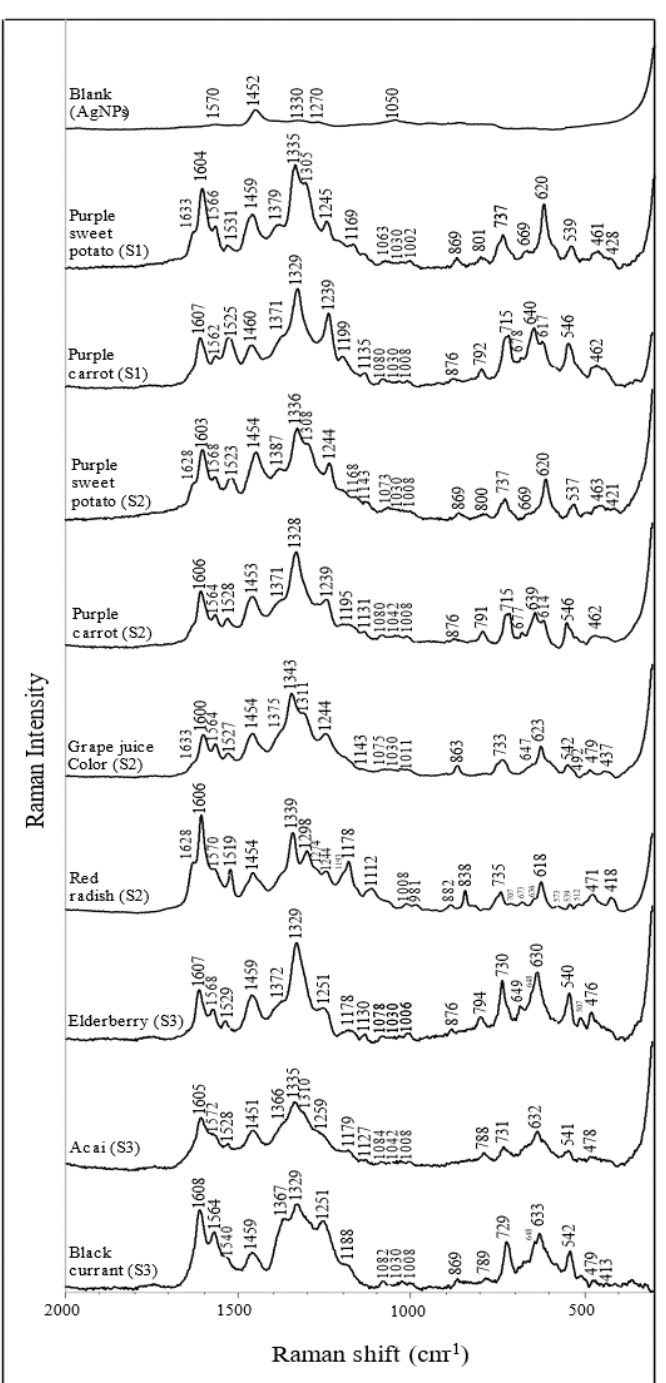
Figure 3. Surface − enhanced Raman spectra of anthocyanin extracts from different plant sources (dried acidified solution).